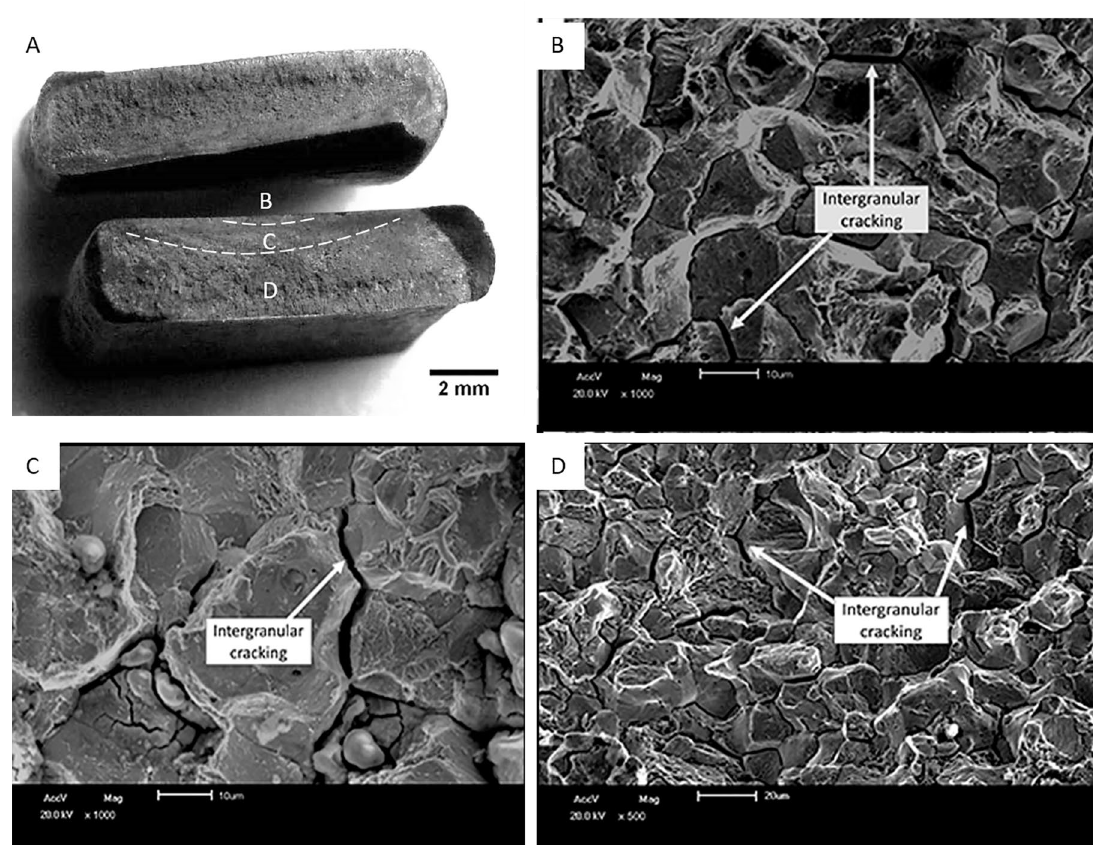
Figure 10. SEM analysis from martensitic material in environment without CP: (A) Overall fracture surface; (B) Initiation region; (C) Propagation region; and (D) Final fracture